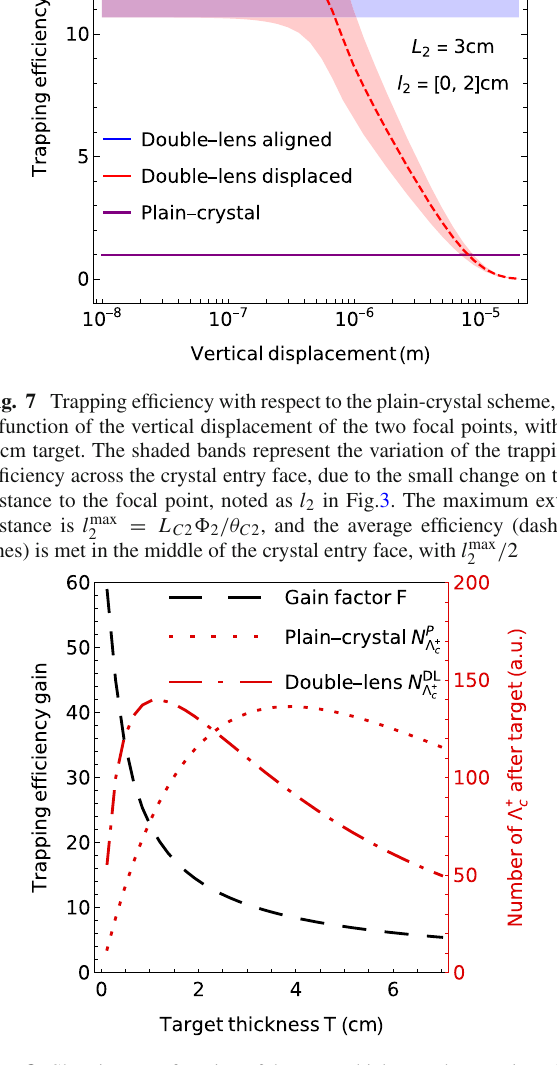
Fig. 8 Showing, as a function of the target thickness, the trapping effi- ciency gain factor F (dashed black); the number of (cid:2) + c after the target, also valid for the plain-crystal scheme (dotted red); and the number of produced-survived-and-trapped (cid:2) + c in the double-lens scheme (dot- dashed red). The optimal target thickness for the double-lens (plain- crystal) scheme is at 0.5cm (2.0 cm), corresponding to a gain factor F ≈